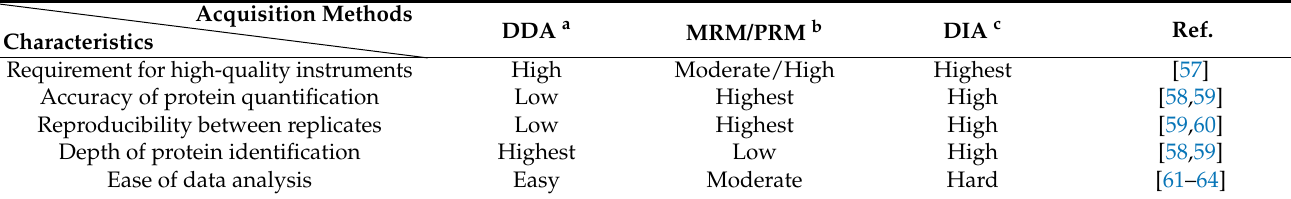
Table 3. Characteristics of LC-MS acquisition